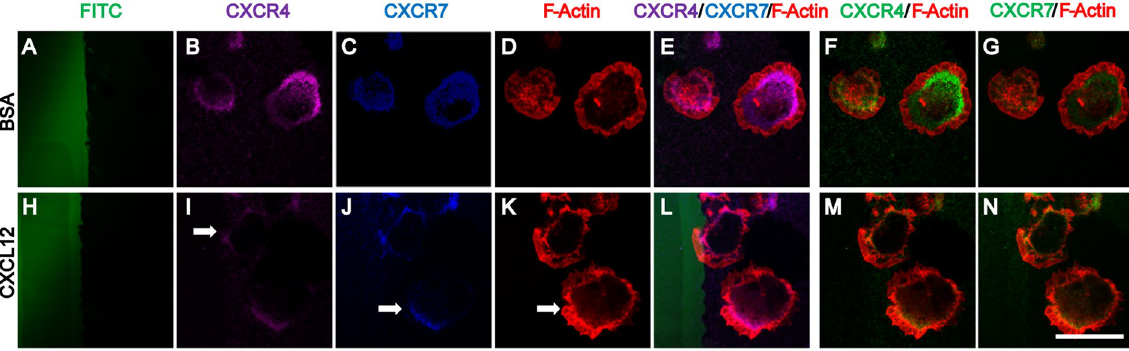
Figure 4. CXCL12 induces CXCR4/CXCR7 and cell polarization in HUVECs. HUVECs were cultured on plastic Petri dishes (pretreated with PDL) with BSA stripes (the control group) and BSA plus CXCL12 stripes (CXCL12 group) for 5 min. HUVECs were fixed and stained with antibodies against CXCR4 (purple), CXCR7 (blue) and F-Actin (red). The micro stripes of fluorescein-conjugated BSA ( A ) or CXCL12 ( H ) are shown. CXCR4 ( B ), CXCR7 ( C ) and F-Actin ( D ) in HUVECs cultured on BSA stripes stayed in the resting state, while the polarization of CXCR4 (arrow: I ), CXCR7 (arrow: J ) and F-Actin (arrow: K ) was observed in HUVECs cultured on CXCL12 stripes for 5 min. Moreover, the HUVECs in the BSA control group showed no morphological changes ( E – G ). The CXCL12 group HUVECs shows polarization towards the CXCL12 stripe ( L – N ). Scale bar: 10 μ